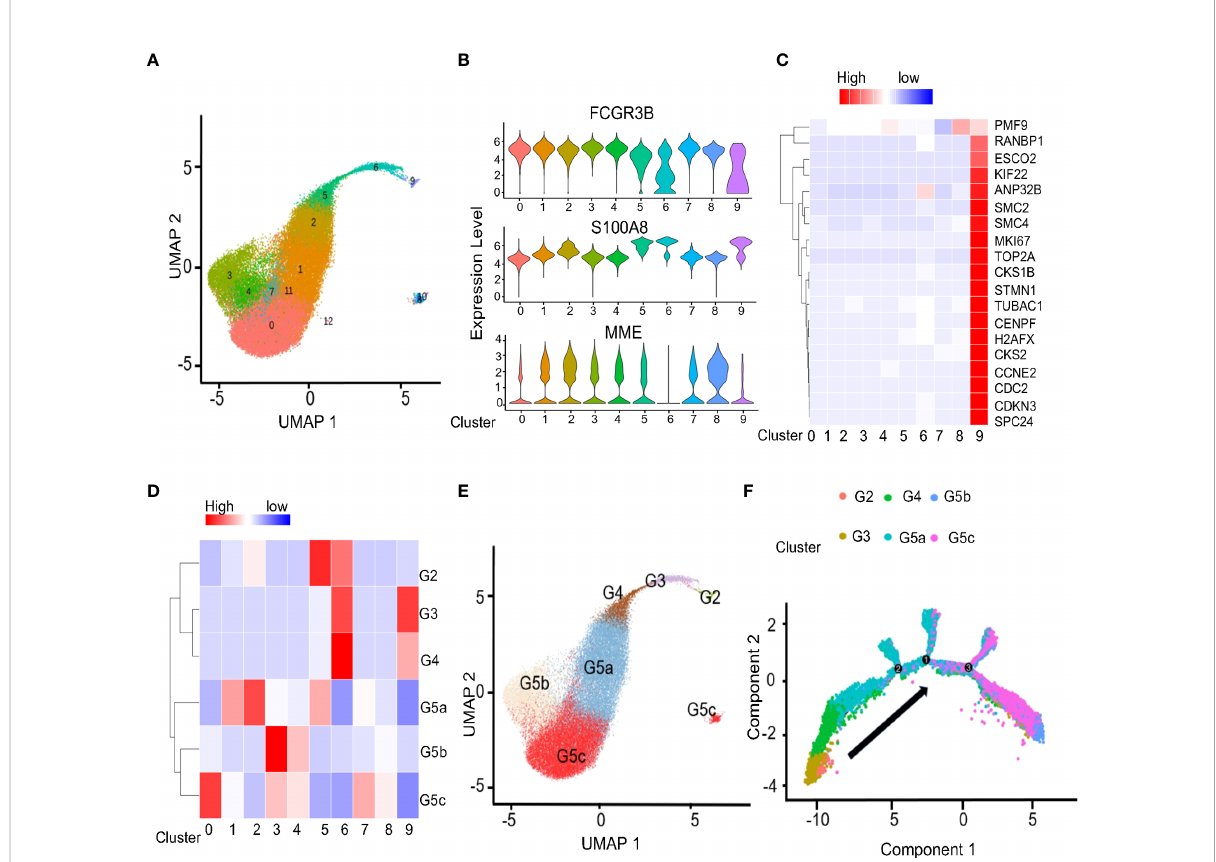
FIGURE 1 Conservative classi fi cation of neutrophils in UCB and healthy adults. (A) Uniform manifold approximation and projection (UMAP) of 45905 neutrophils from UCB and healthy adult. (B) Violin plots of the genes FCGR3B, S100A8 and MME in populations. (C) Heatmap showing row-scaled expression of cell cycle-related genes for 0-9 clusters neutrophils. (D) Correlation of scRNA-seq de fi ned neutrophil clusters with the neutrophil subtypes reported by Xie et al. (E) Projection of new clustering results on UMAP. (F) Pseudo-time analysis of neutrophils. The order of cells was inferred from the expression of the most variable genes in all cells, and the direction of development was determined from biological